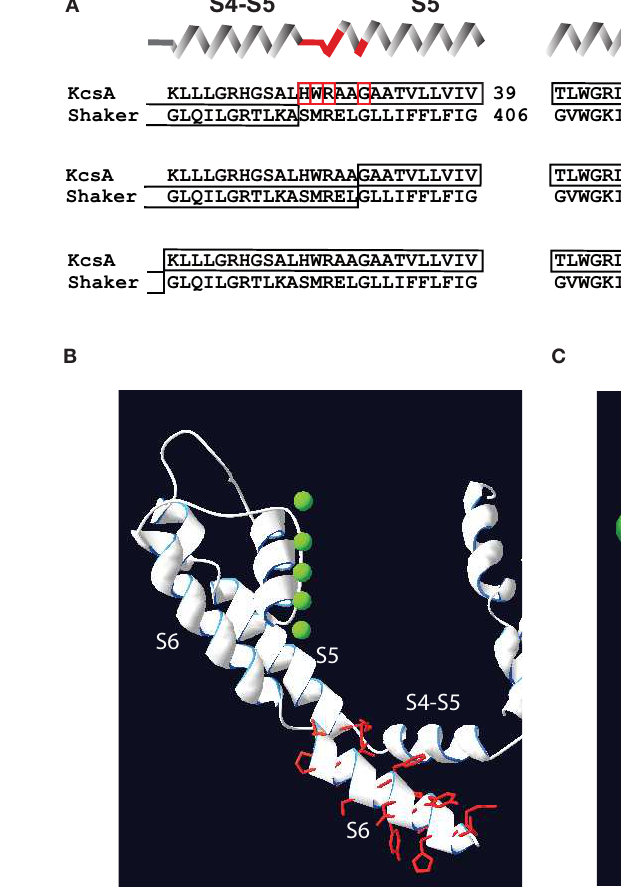
FIGURE 2 | Localization of mutations susceptible for constitutive conductance in Shaker -KcsA chimeric channels according to recent Kv crystals. (A) Three groups of KcsA- Shaker chimeras that demonstrated partial or almost complete constitutive activation are shown separately. Secondary structure succession pattern on the top of sequence alignments corresponds to the recent crystal structure of the Kv1.2–Kv2.1 chimera (Long et al., 2007).